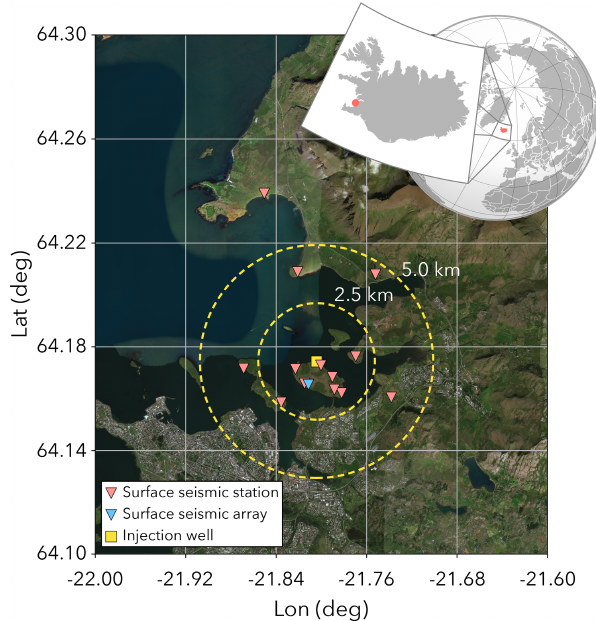
Figure 1. Map view of the Geldinganes peninsula, the injec- tion well, and seismic network. Source of the map: map data © 2019 Google